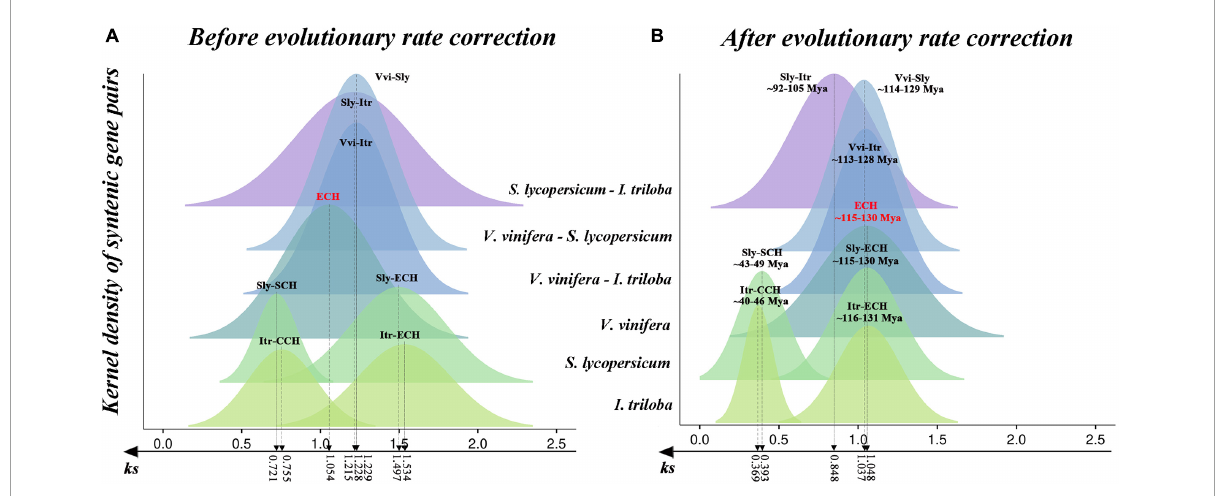
FIGURE1 Original and corrected Ks distribution among syntenic genes within and between genomes of Solanum lycopersicum (Sly), Ipomoea triloba (Itr), and Vitis vinifera (Vvi). (A) Distribution of Ks values between syntenic blocks before correction. (B) Distribution of Ks values among syntenic blocks after evolutionary rate correction. The different colored peaks indicate the normal distribution of the Ks values of syntenic